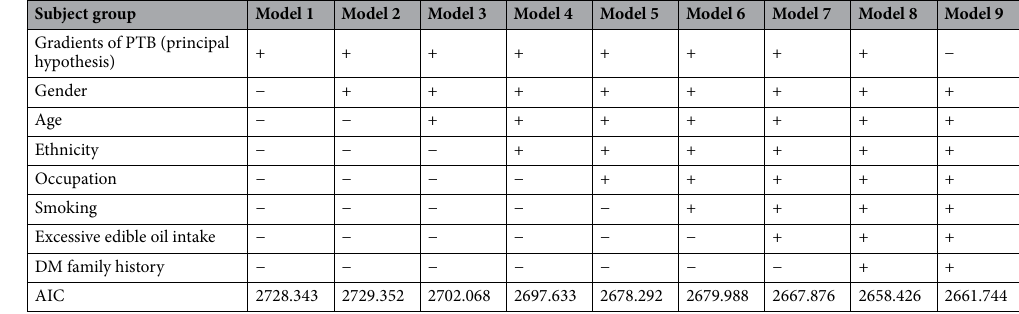
Table 3. Proportional odds logistic regression analysis to choose the best model for assessing the gradient association of tuberculosis on developing diabetes mellitus among households with a tuberculosis case, 2020. Excessive edible oil intake: intake of edible oil over 30 g/day/adult. Smoking: smoking in the past 12 months, including both daily and non-daily smoking.